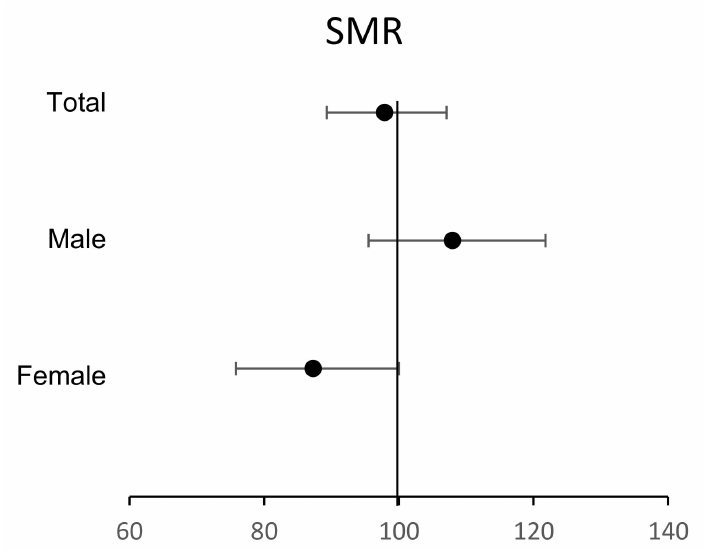
Figure 4. Forest plot of observed total deaths stratified by gender and cancer type (SMR). An SMR < 100 indicates fewer than expected deaths. An SMR = 100 indicates observed deaths equal expected deaths. An SMR > 100 indicates there were excess deaths.